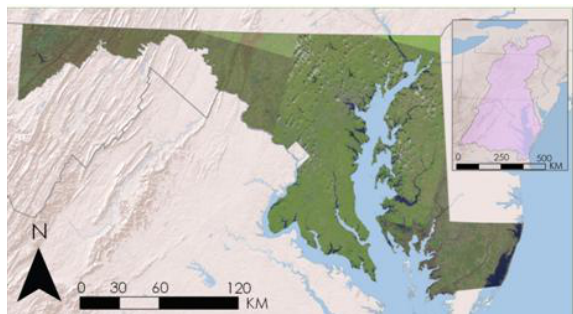
Figure 1. Study area, Maryland, as a mosaic of Landsat 8 OLI images. The Chesapeake Bay watershed is highlighted in the inset. Source: Landsat 8 OLI (NASA), Maryland County Boundaries (Maryland GIS Data Catalog), World Shaded Relief (ESRI), State Boundaries (ESRI).